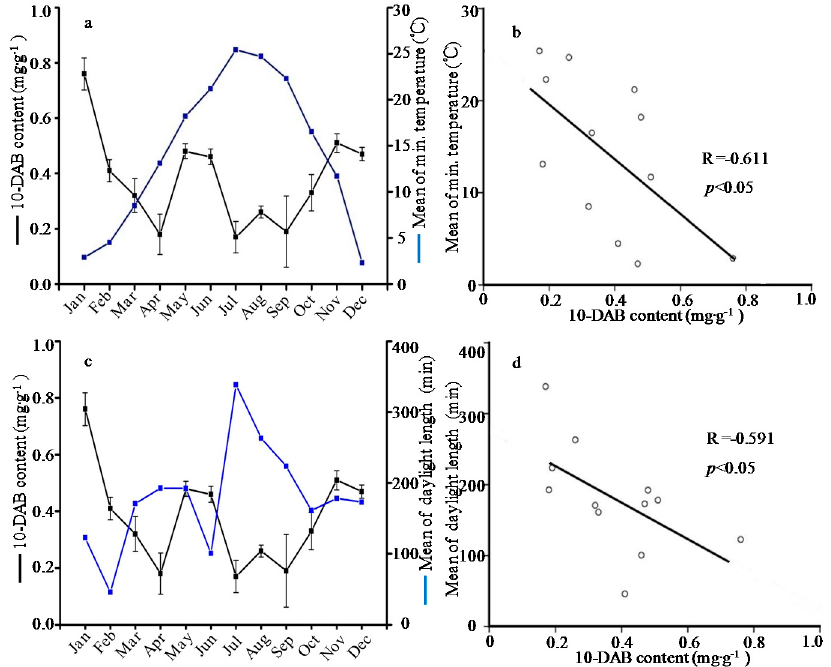
Figure 2. Relationship ( a ) and correlation ( b ) between 10-deacetylbaccatin III (10-DAB) content and mean of minimum temperature; and relationship ( c ) and correlation ( d ) between 10-DAB content and mean of daylight length.